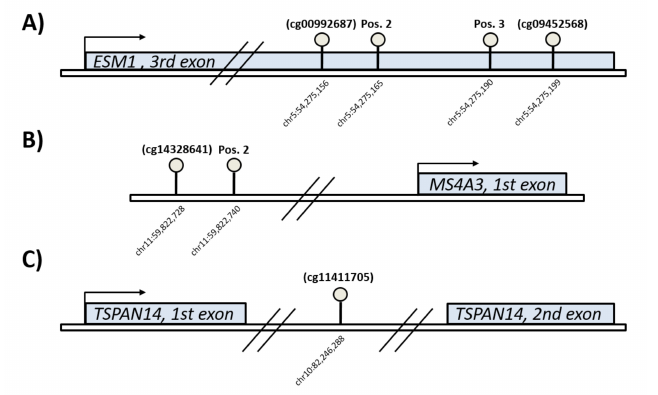
Figure 2. Schematic representation of the genomic location of the target CpGs associated with the genes ESM1 (Endothelial cell specific molecule 1) ( A ), MS4A3 (Membrane spanning 4-domains A3) ( B ), and TSPAN14 (Tetraspanin 14) ( C ). Differentially methylated CpGs detected in the previous cohort of adolescent offspring are shown by their cg number, while the other indicated sites are neighboring CpGs included in the pyrosequencing